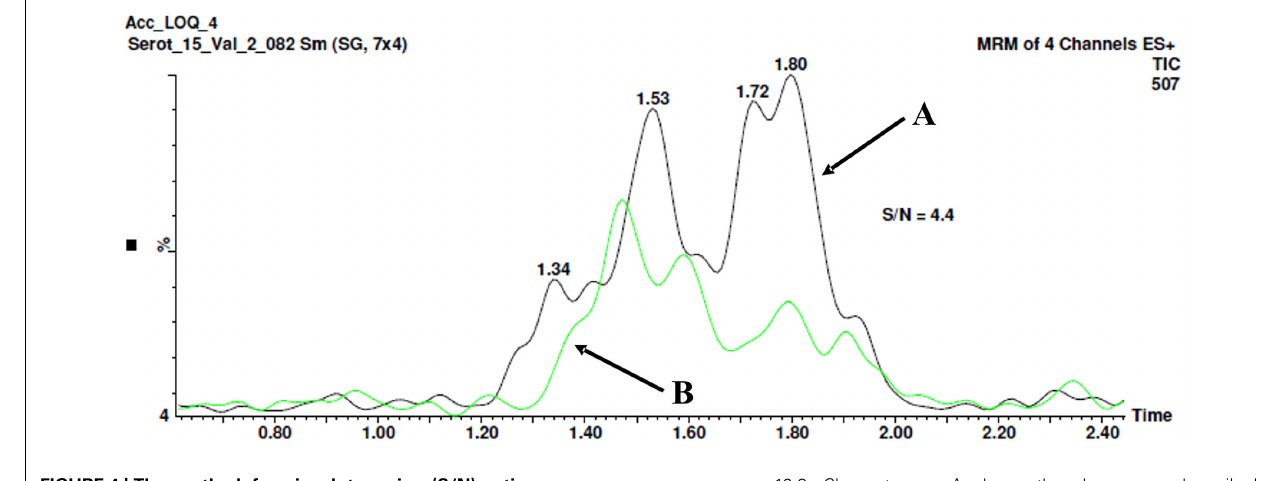
FIGURE 4 | The method for signal to noise (S/N) ratio determination. Chromatogram B shows the “clean” plasma sample no spiking with 5-HT-SO4. The peak with a retention time 1.8min. is